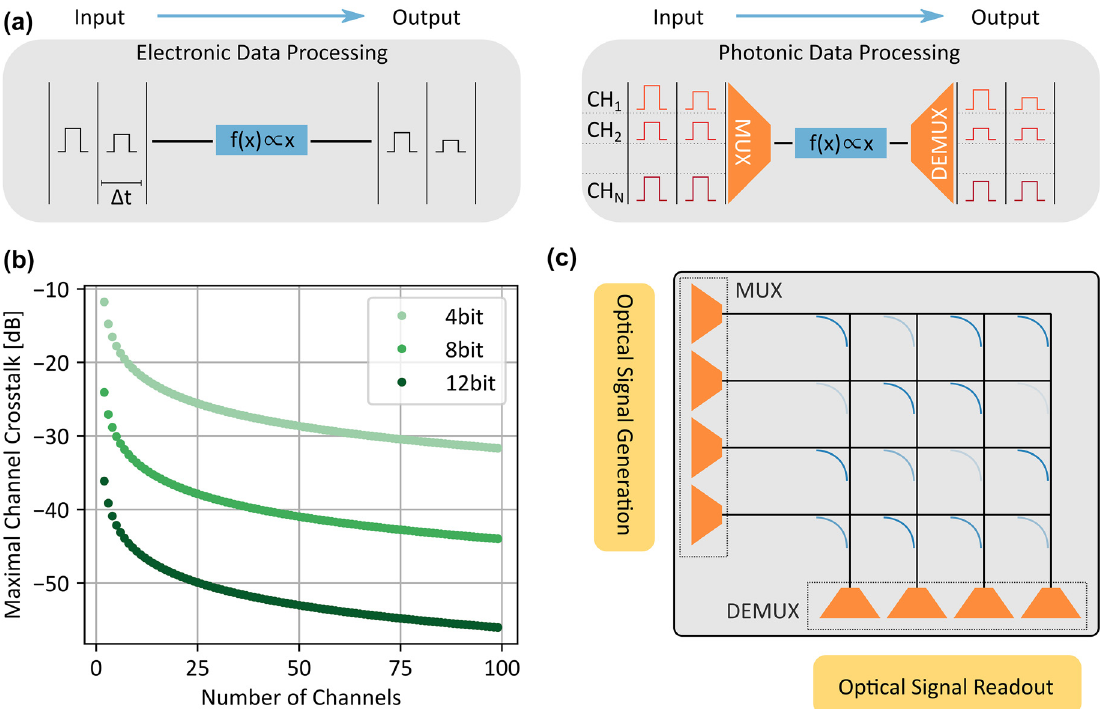
Figure 1: Parallel photonic data processing. (a) Comparison between electrical and optical data processing. A single electronic computation unit can only process a single inputwithin a time bin Δ t . Incontrast, several inputs are processedinparallel with a photonic computation unit by deploying wavelength division multiplexing (WDM). (b) Maximal allowed crosstalk between the MUX/DEMUX channels. WDM adds an additional noise source to the computation due to crosstalk between the computation channels which potentially limits the precision of the operation. (c) Sketch of the fabricated photonic tensor core. Here, ultra-low crosstalk multiplexers are integrated with the photonic crossbar array on the same silicon nitride chip. The optical signal generation and signal readout is performed